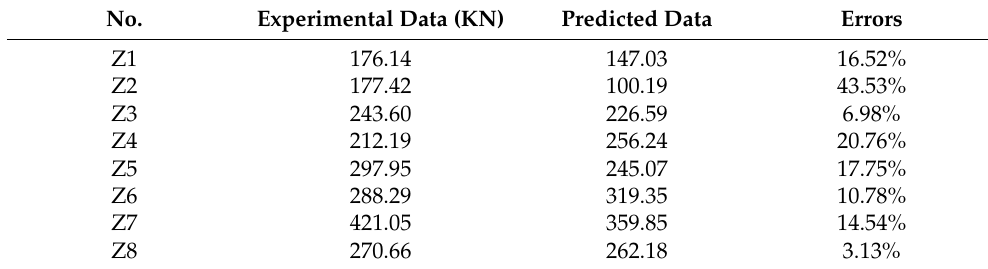
Table 9. Comparison of experimental data and predicted data for yield strength.